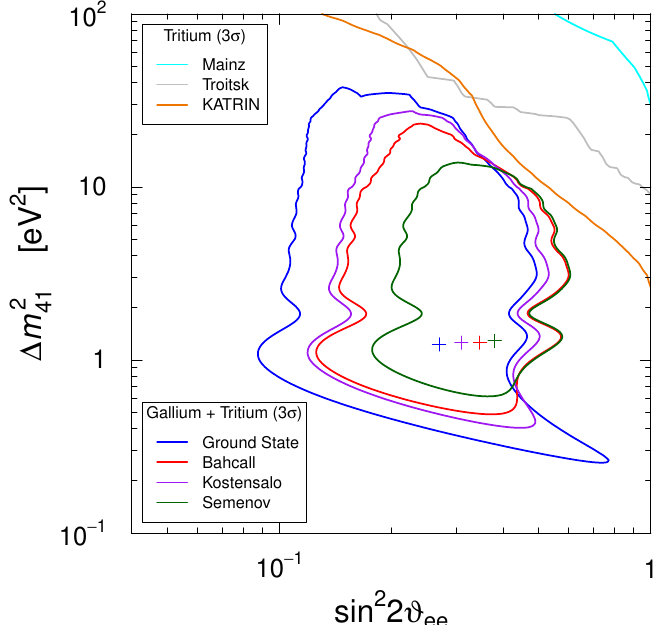
Figure 8. Contours delimiting the 3 σ allowed regions in the ( sin 2 2 ϑ ee , ∆ m 2 the combined analysis of the Gallium data with different cross sections and the Tritium data. The figure shows also the 3 σ exclusion curves of the Mainz, Troitsk, and KATRIN Tritium